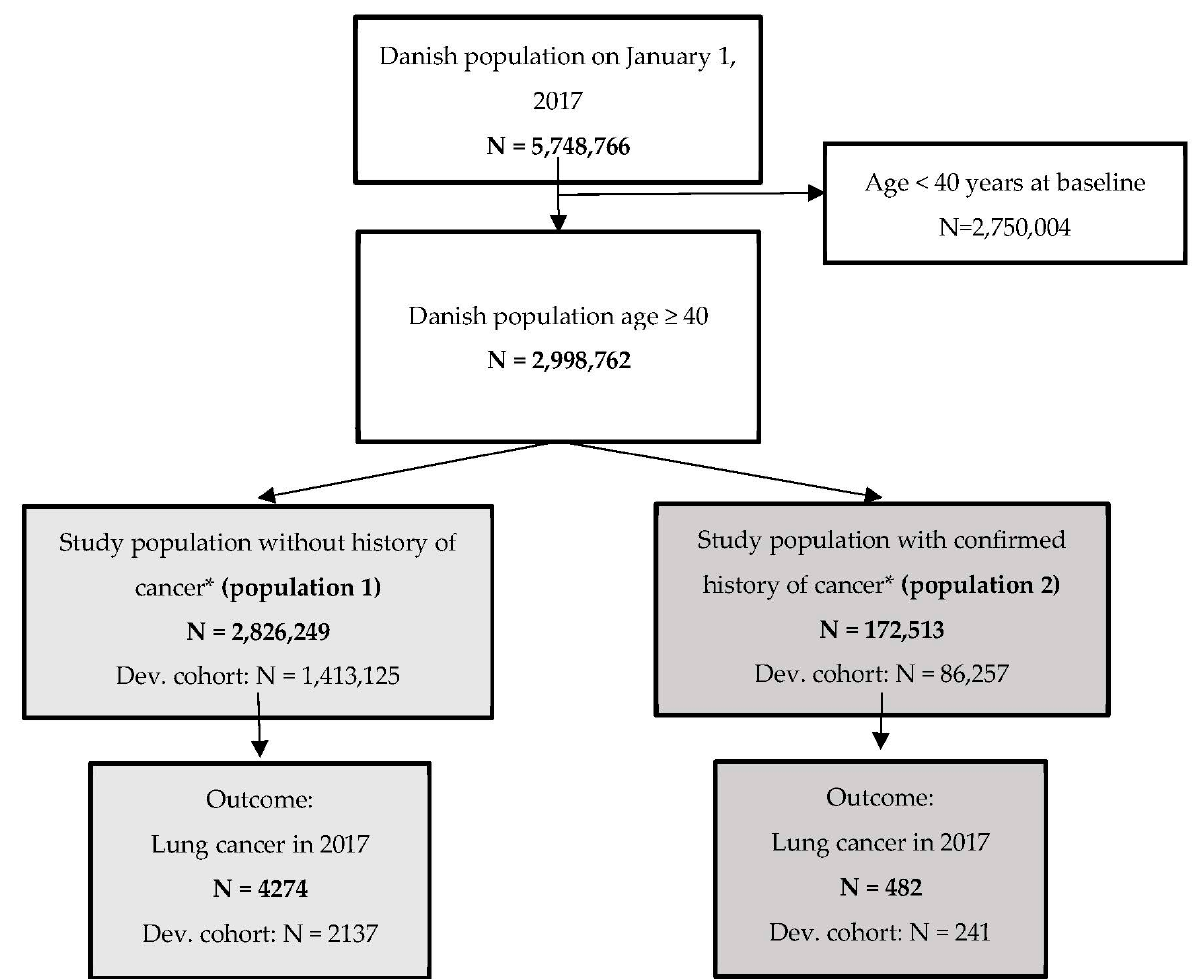
Figure 1. Flow chart of the study population without a history of cancer (population 1), and the study population with a history of cancer (population 2). * In the period 2007–2016.